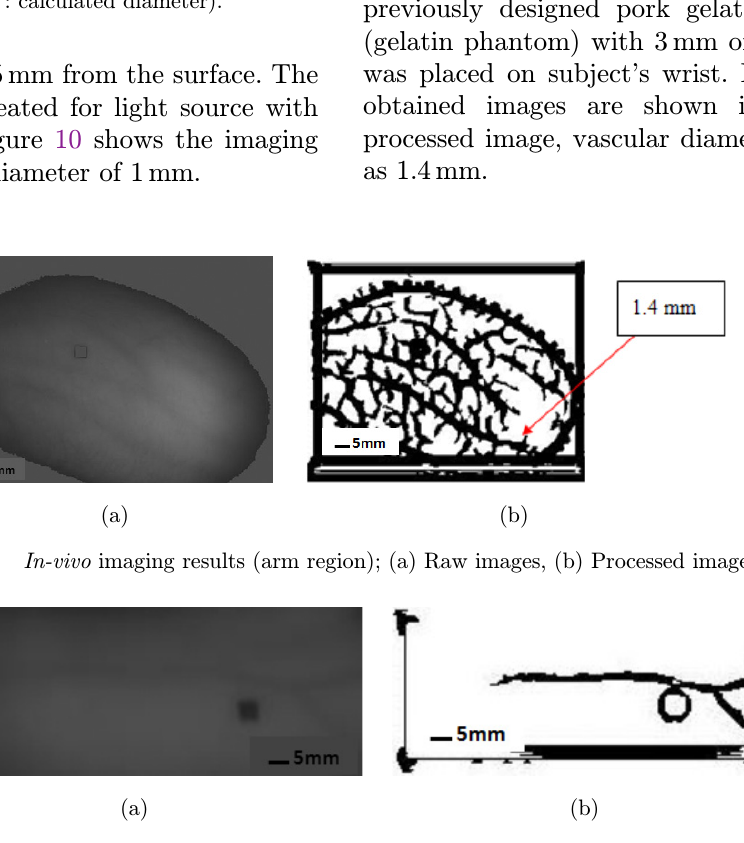
Fig. 12. The results of in-vivo imaging for wrist region; (a) Raw image, (b) Processed